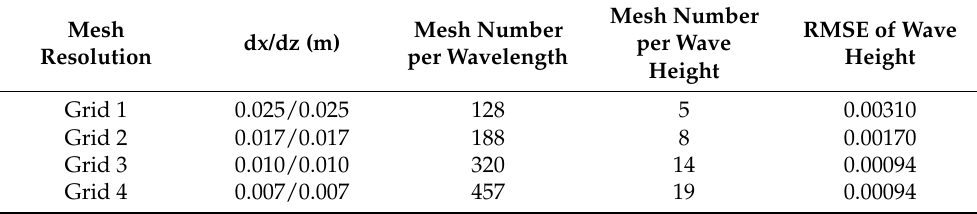
Table 2. A comparison of the root-mean-square difference (RMSD) values determined by the grid convergence test.